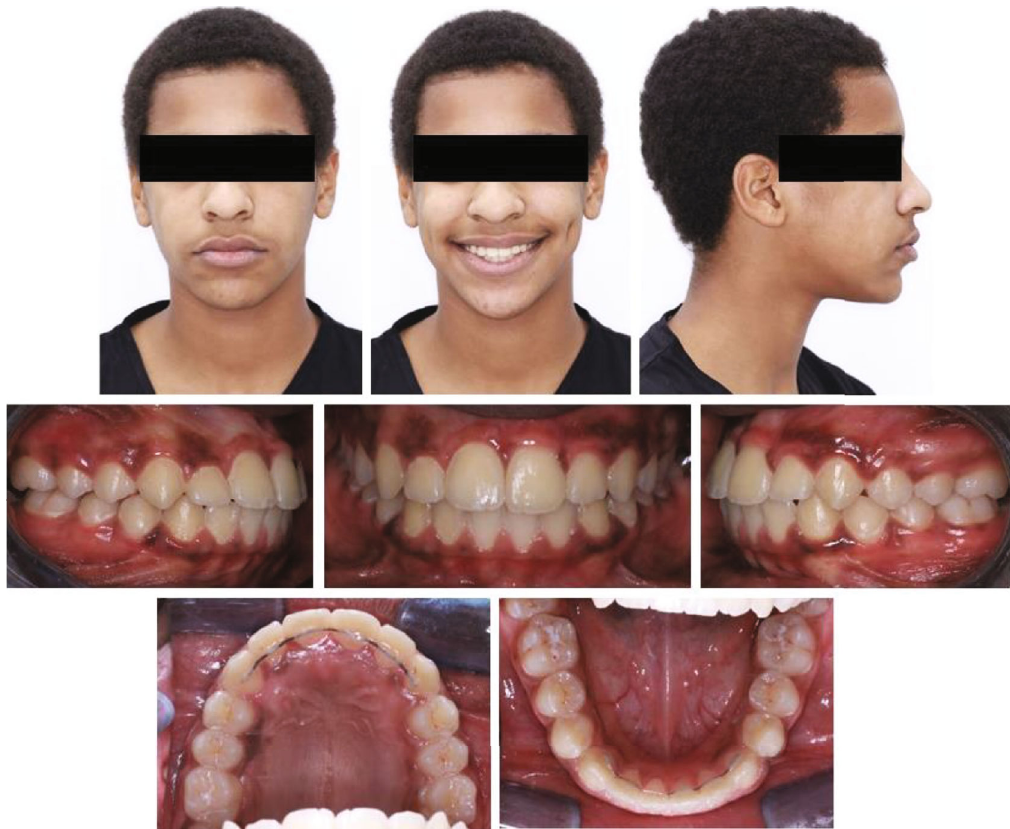
Figure 9: Posttreatment extra- and intraoral